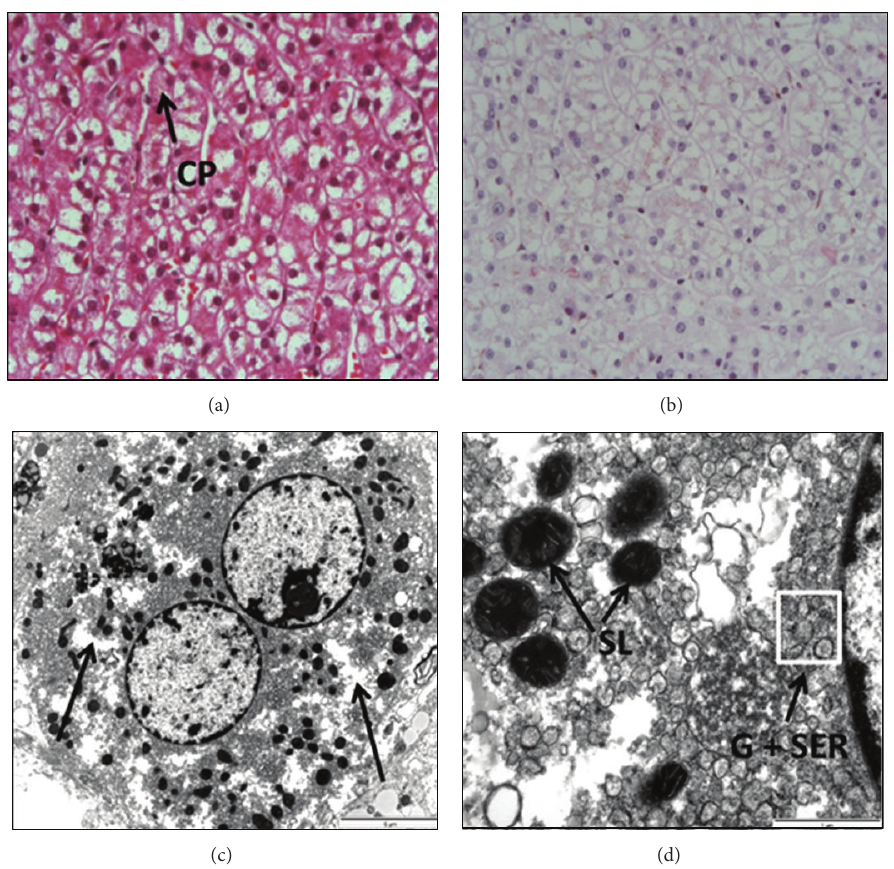
Figure1:Histologyandelectronmicroscopy.(a)Normalliverlobulewithpalehepatocytesandceroidpigments(CP)attheirapicalpole(H&E staining, original magnification × 400). (b) Diffuse clarification of hepatocytes in relation with marked glycogen reduction (PAS staining). (c) Electron microscopic appearance of a typical hepatocyte showing glycogen deficit (white areas). (d) Overview of the cytoplasm of a typical hepatocyte at electron microscopy. Low density of rough endoplasmic reticulum, mitochondria, and primary lysosomes. Increased number and hyperplasia of smooth endoplasmic reticulum (SER) and Golgi (G) apparatus (white box). Secondary lysosomes (SL) considered in